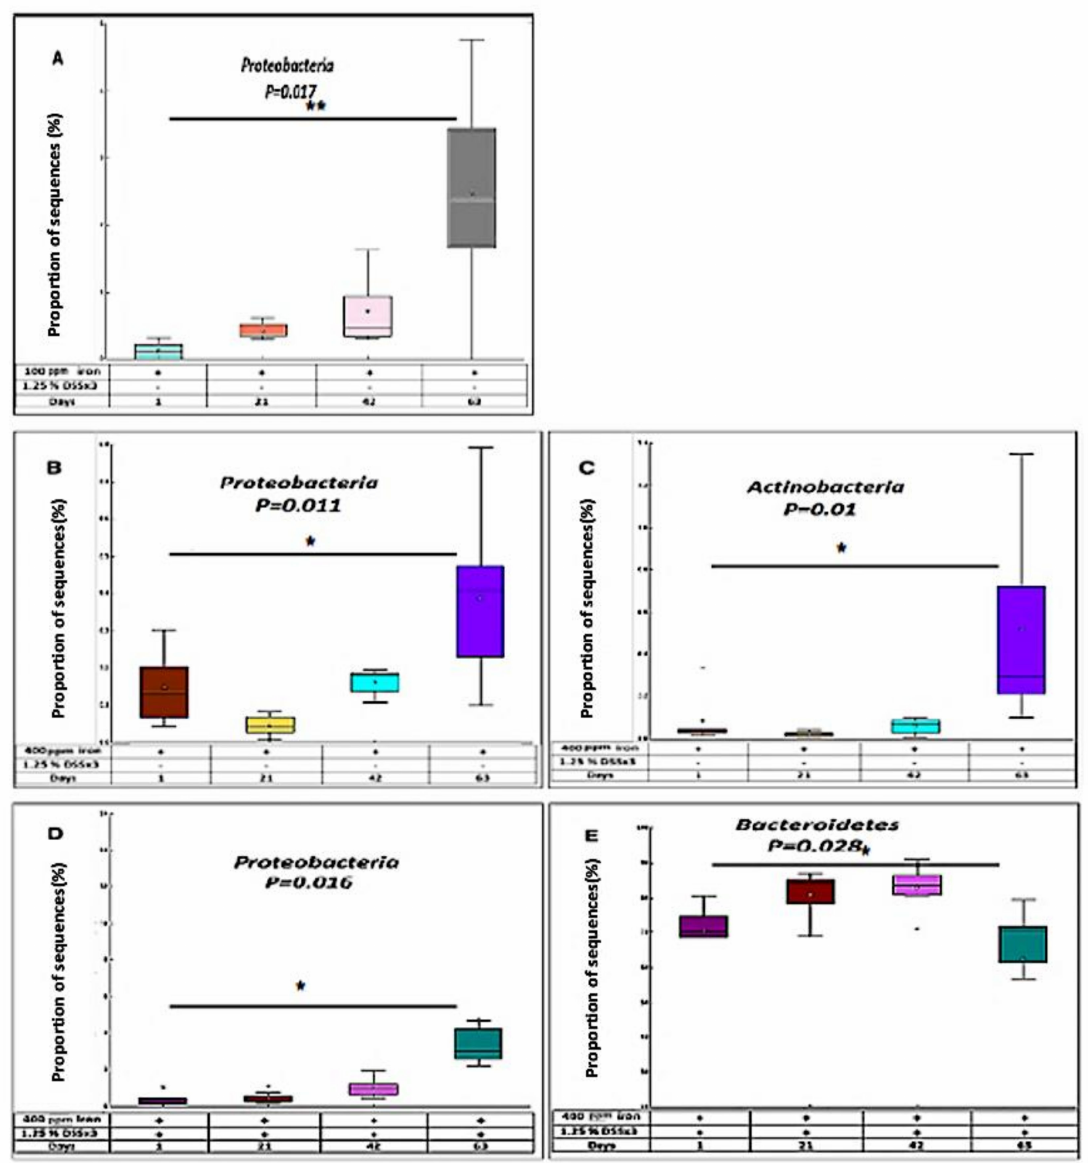
Figure 5. Distribution of bacteria in response to chronic DSS. ( A ) In chronic DSS, box plot showing the distribution in the proportion of Proteobacteria assigned to samples at day-1, 21, 42, and 63 from 100 ppm iron DSS-treated mice. In chronic DSS, box plot showing the distribution in the proportion of two phyla ( Proteobacteria ( B ) and Actinobacteria ( C )) assigned to samples from 400 ppm iron untreated mice. In chronic DSS, box plot showing the distribution in the proportion of two phyla ( Proteobacteria ( D ) and Bacteroidetes ( E )) assigned to samples from 400 ppm iron DSS-treated